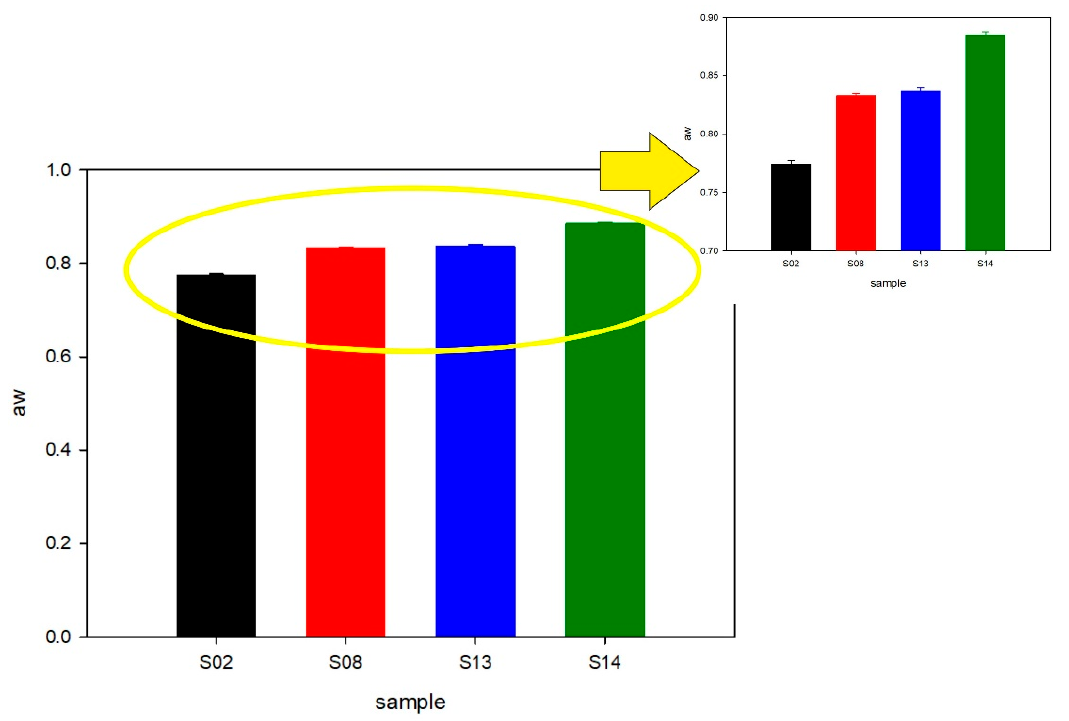
Figure 8. Water activity (aw) results.